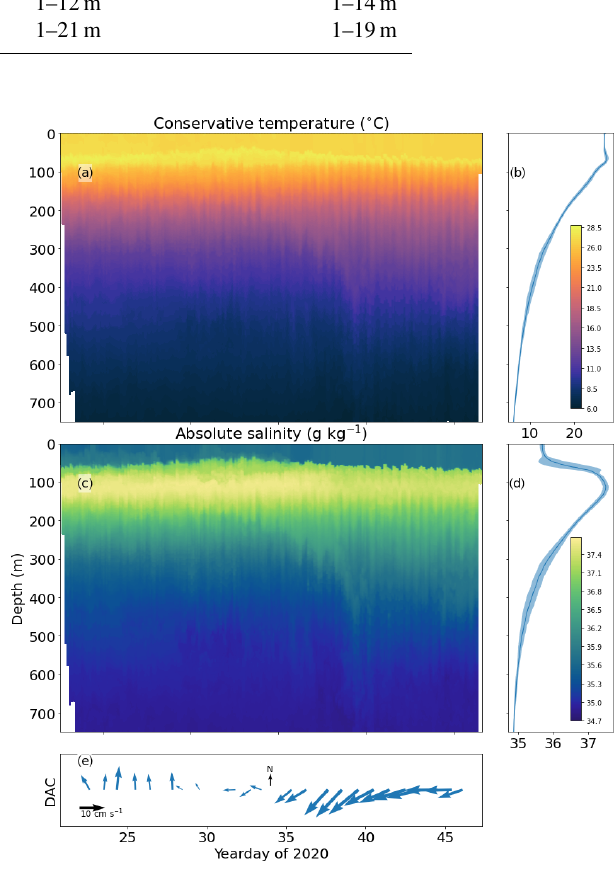
Figure 8. (a) Gridded mean conservative temperature from SG637. (b) Mean conservative temperature profile with uncertainty of 1 standard deviation shaded. (c, d) As (a) , (b) for absolute salinity. (a, c) Gridding is 1m vertically performed on a per-profile basis. (e) Daily mean of the dive average current (DAC). Glider data from the tropical North